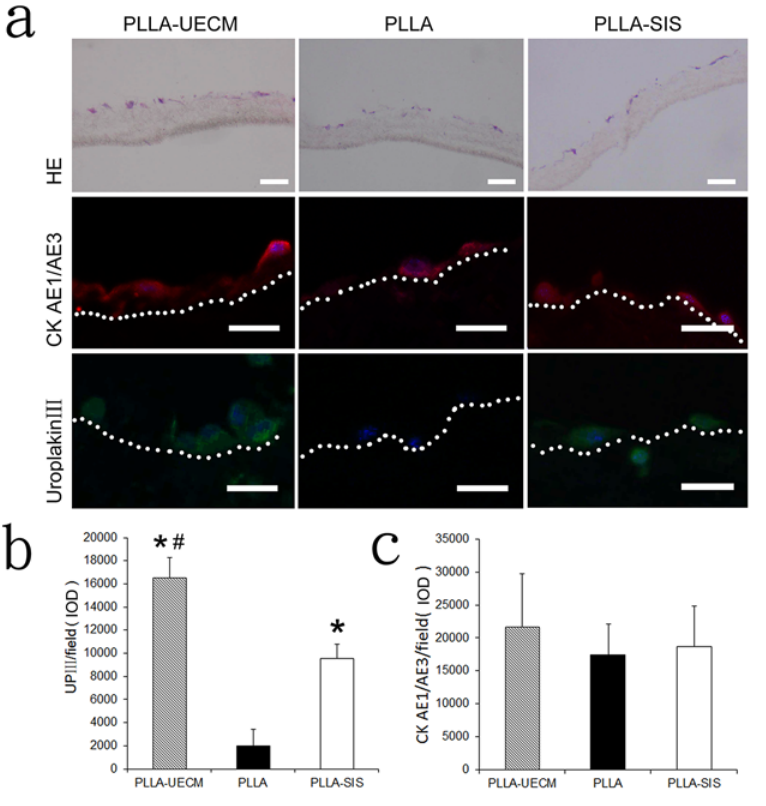
Fig 3. (a) H&E staining showed that the seeded cells remained in the scaffolds and mainly gathered on the surface of the scaffolds.Immunofluorescence staining showed that more cells present in the PLLA-UECM scaffold were positive for UPIII compared to those in the PLLA and PLLA-SIS groups. Image analysis by IPP revealed that there was more UPIII expression in the PLLA-UECM group than in the other two groups (b). However, the expression of the non-specific marker CK AE1/AE3 was not significantly different between groups (c). Inset scale bar = 20 μ m. #: p < 0.05 versus the PLLA-SIS group; * : p < 0.05 versus the PLLA group. The region below the white dotted line represents the scaffold.